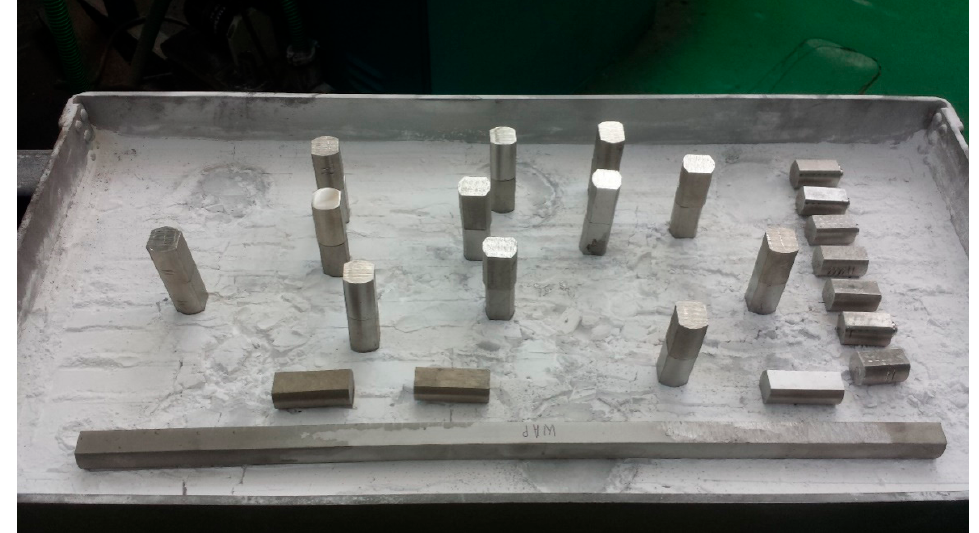
Figure 1. The arrangement of the sections of rods in a molybdenum bath.